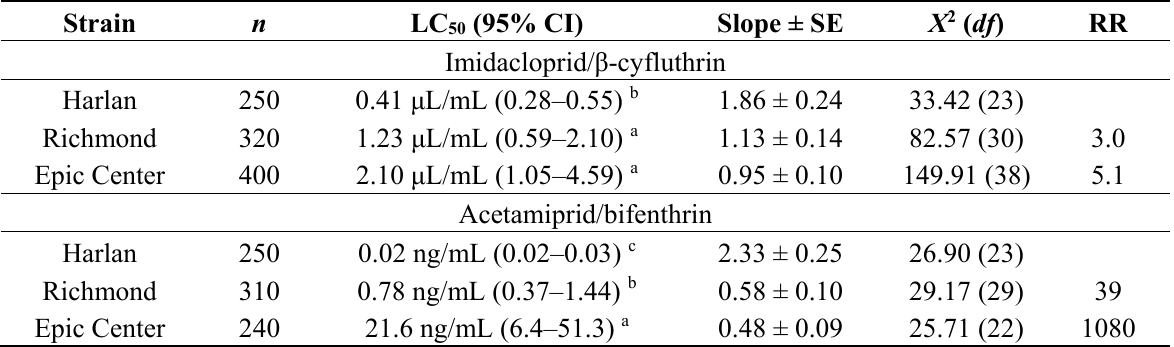
Figure 1. Mean (±SEM) bed bug egg percent mortality of a pyrethroid-susceptible strain (Harlan) and two pyrethroid-resistant strains (Richmond and Epic Center) after treatment with deltamethrin (0.06%). Five replications of 10 bed bug eggs were dipped into three concentrations of deltamethrin for a total of n = 50 at each tested concentration. Table 1. Comparison of bed bug egg LC 50 values when exposed to 5 different concentrations of imidacloprid/ β -cyfluthrin and acetamiprid/bifenthrin for a pyrethroid-susceptible strain (Harlan) and two pyrethroid-resistant strains (Richmond and Epic